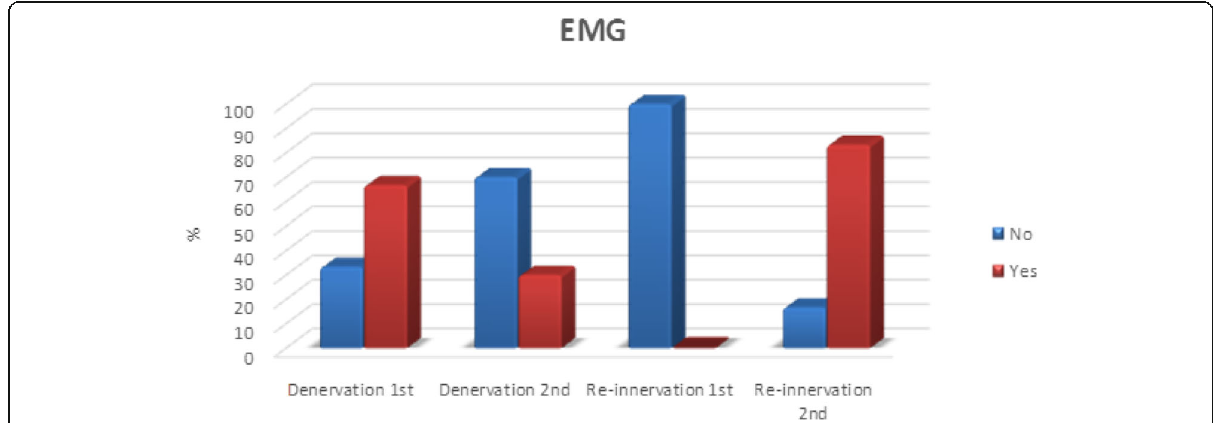
Fig. 5 EMG among the studied patients at 1st and 2nd evaluation